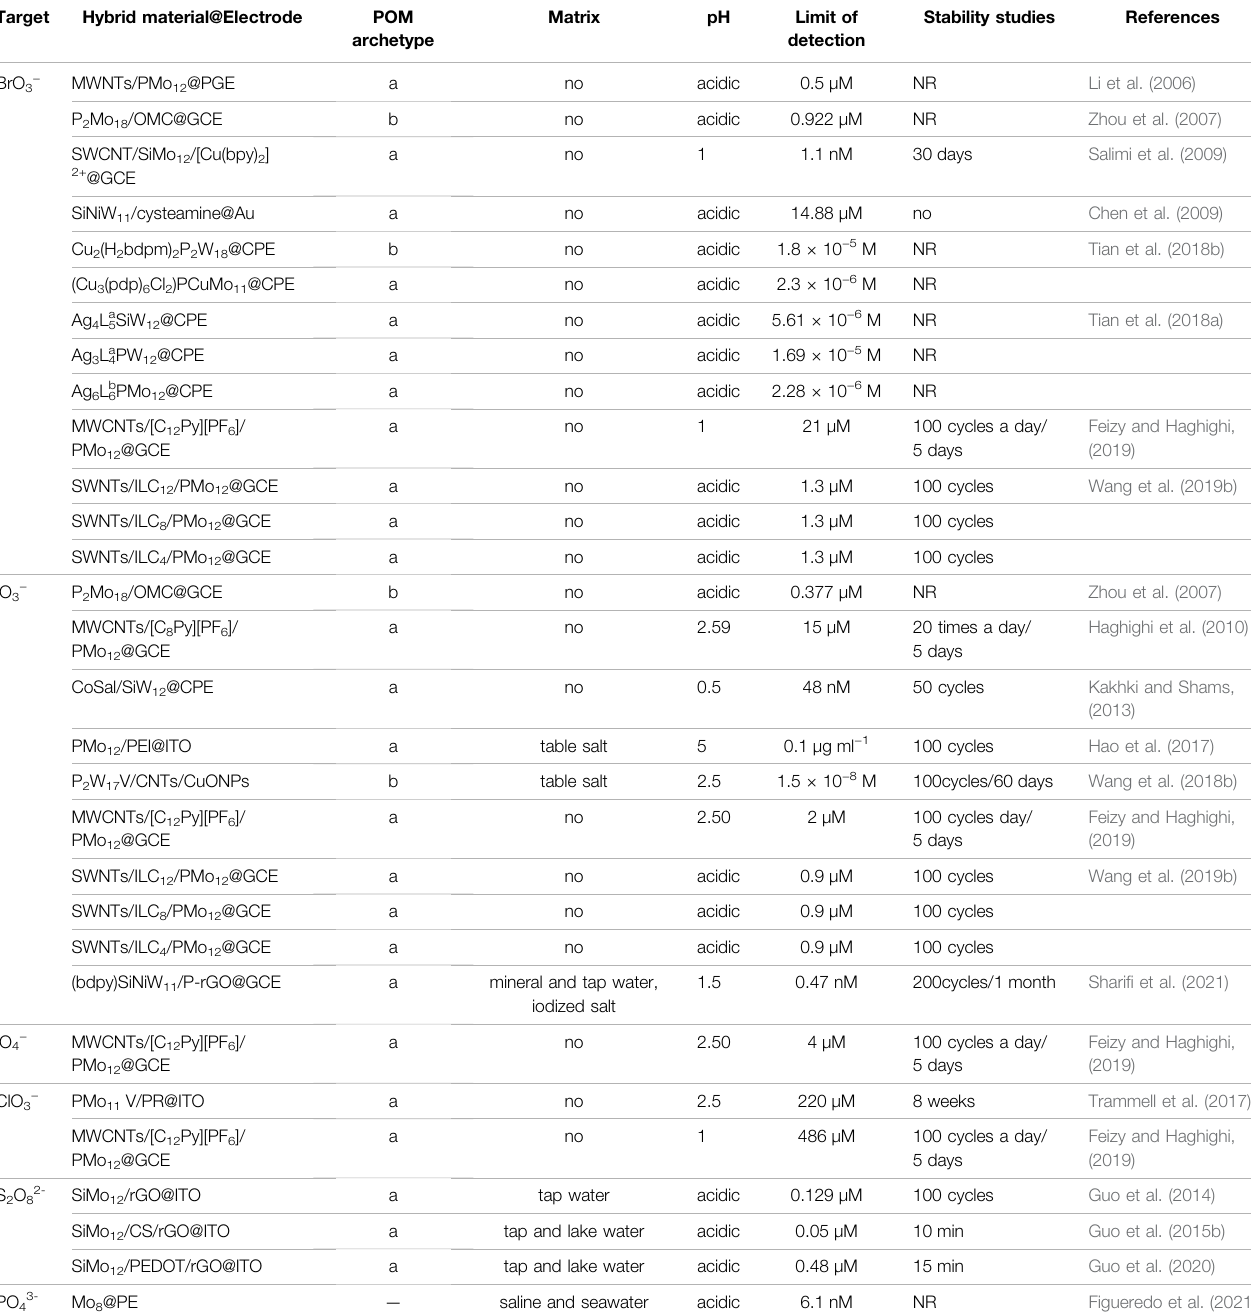
TABLE 3 | POM-based electrochemical sensors for other oxidants species. Target